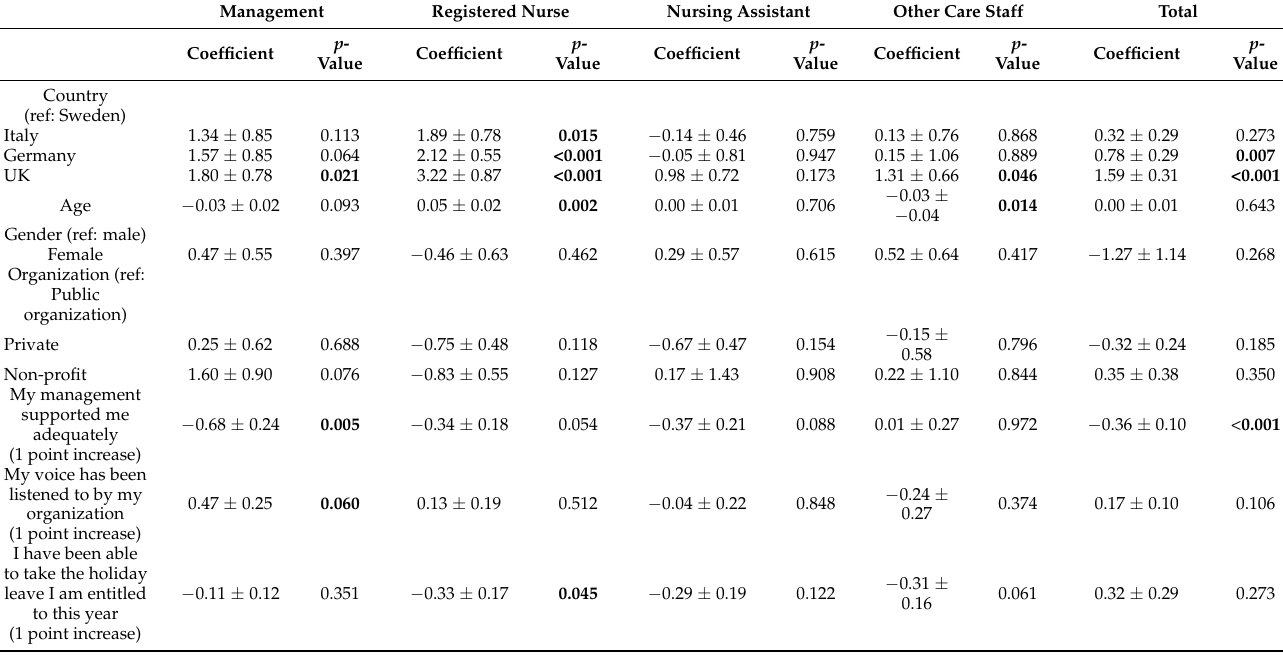
Table 5. Factors associated with stress level among the professionals by